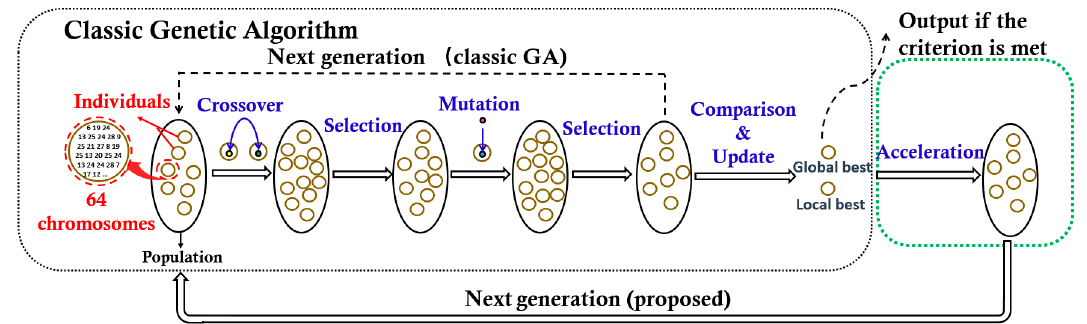
Figure 6. One generation procedure of the proposed algorithm (the arrow of the dotted line indicates the data flow direction of the genetic algorithm (GA) algorithm).